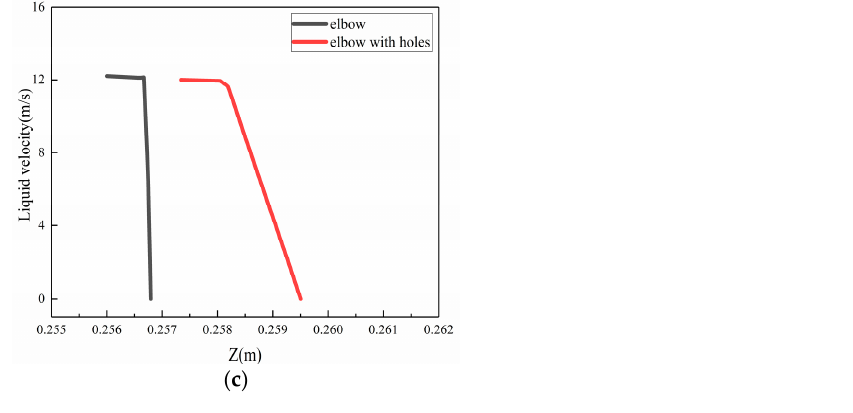
Figure 25. The velocity near the wall: ( a ) location 1; ( b ) location 2; ( c ) location3.